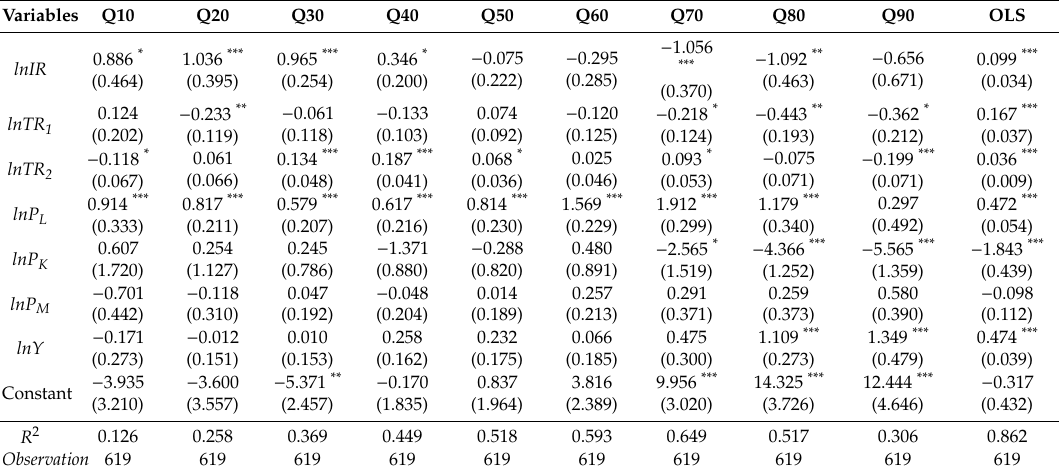
Table 2. Results of unconditional quantile estimation and ordinary least square (OLS)